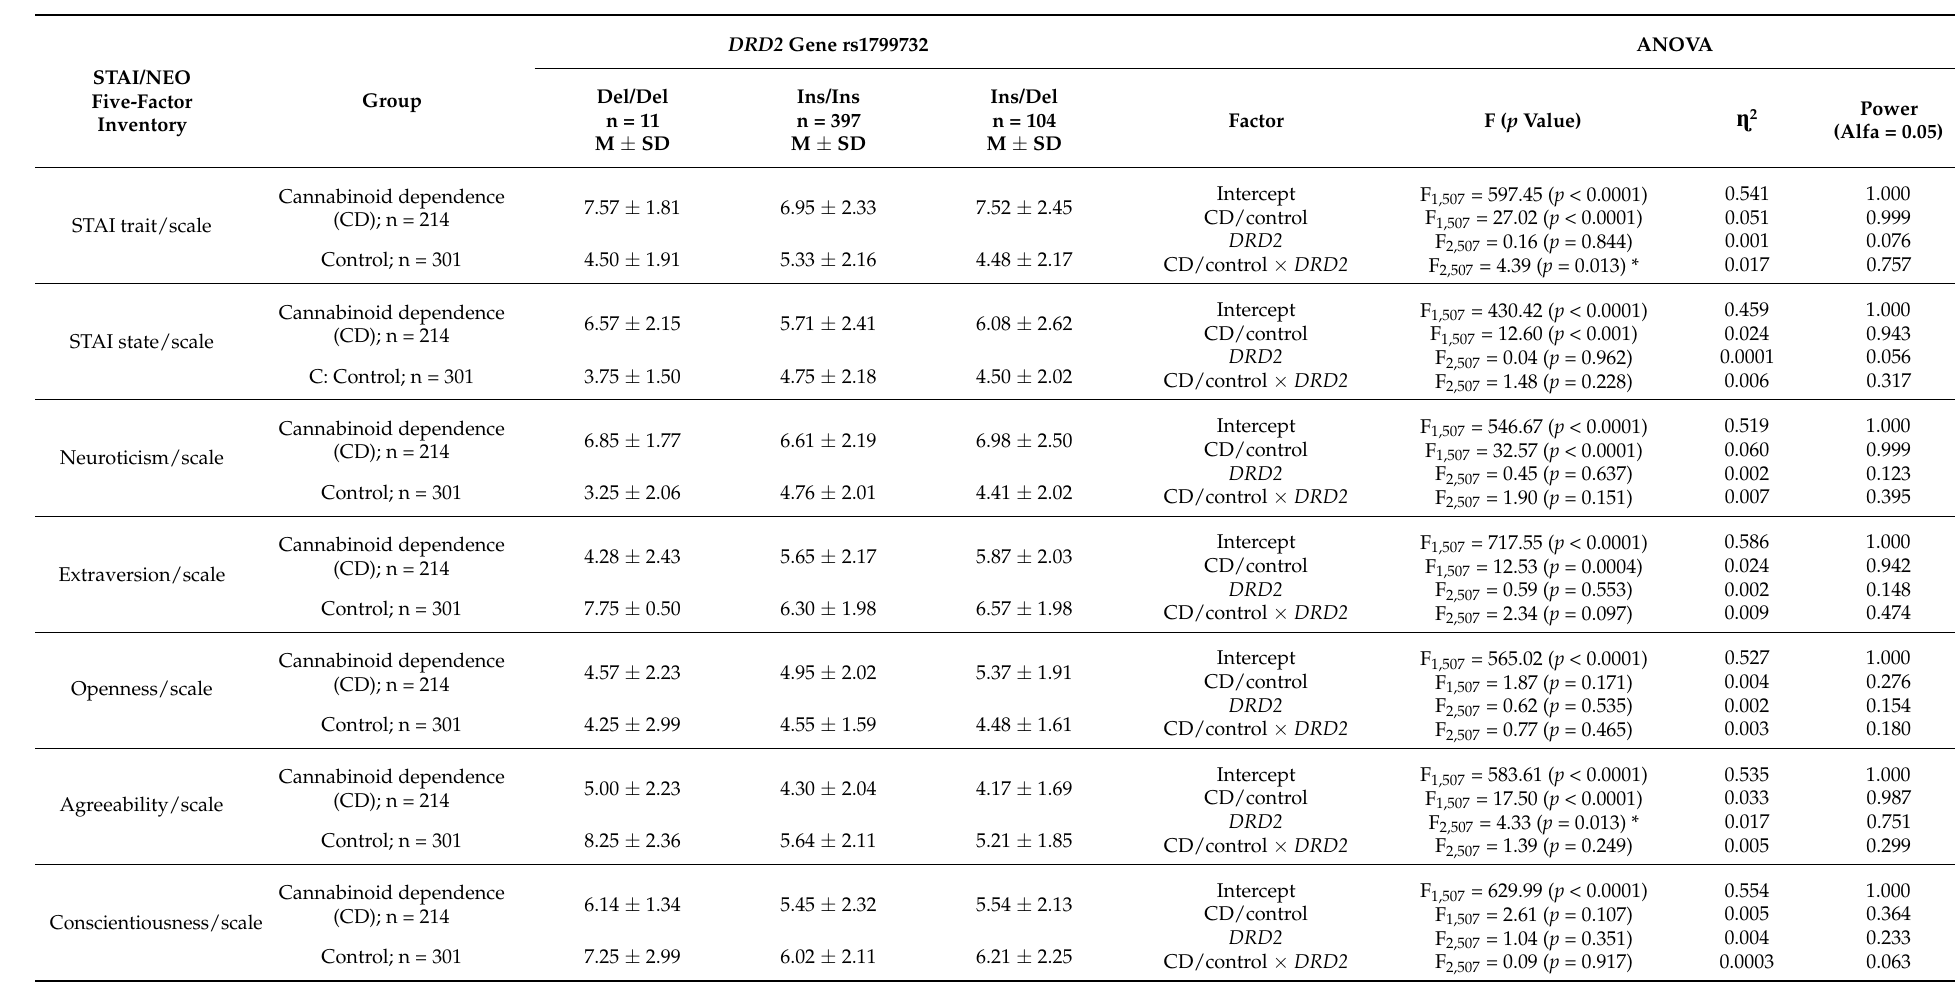
Table 4. Differences in the DRD2 gene rs1799732 and NEO Five-Factor Inventory, STAI scale between healthy control subjects and cannabinoid dependence.